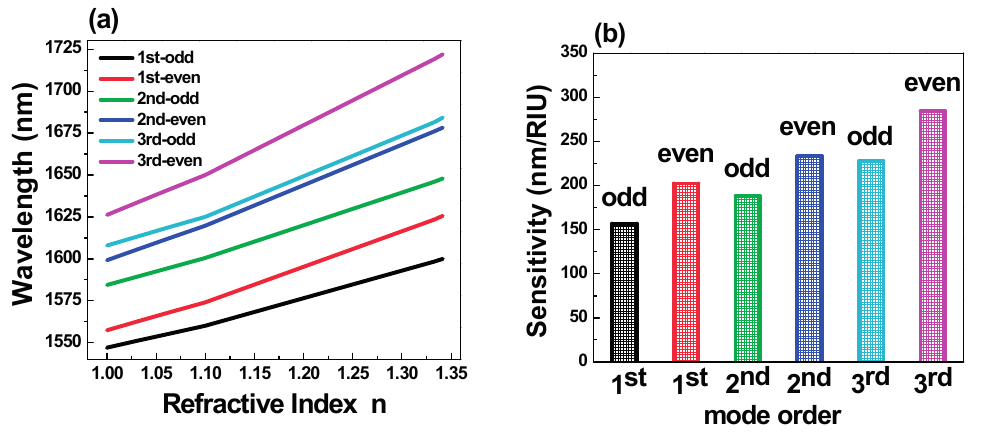
Figure 5. ( a ) Refractive index n versus wavelength shift ( Δλ ); ( b ) the sensitivity (S = Δλ / Δ n ) of even and odd modes in the laterally-coupled PhC NB cavity